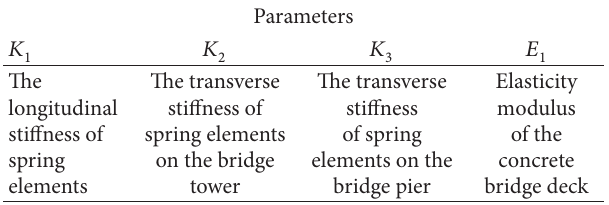
Table 5: Parameters